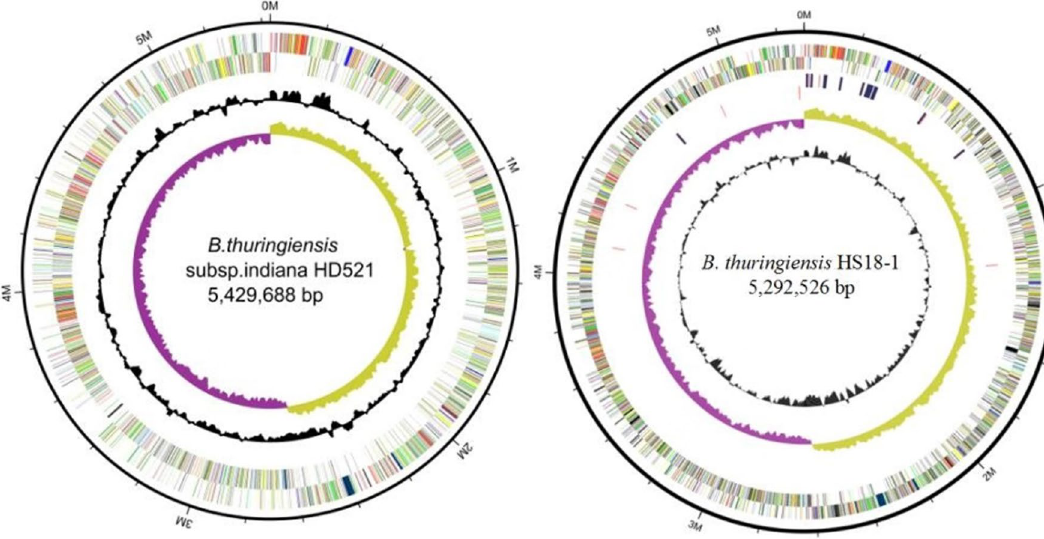
Figure 1. Circular pictorial representation of chromosome of both Bt strains; ( A ) Bt strain HD521 and ( B ) Bt strain HS18-1. From outside to center: the first circle, the forward strand of DNA; the second circle, the reverse strand of DNA; the third circle GC content (black), the fifth circle GC